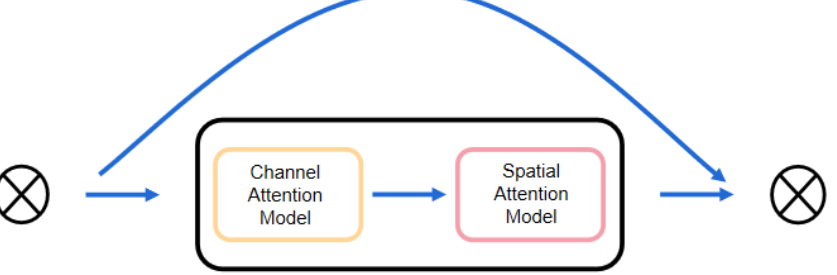
Figure 6. Structure of the Res-Attention module for reducing information loss during transmission. The network flow diagram of the Res-Attention module is shown in Figure 7, which gives a more intuitive view of the transmission process of the feature map in the Res- Attention